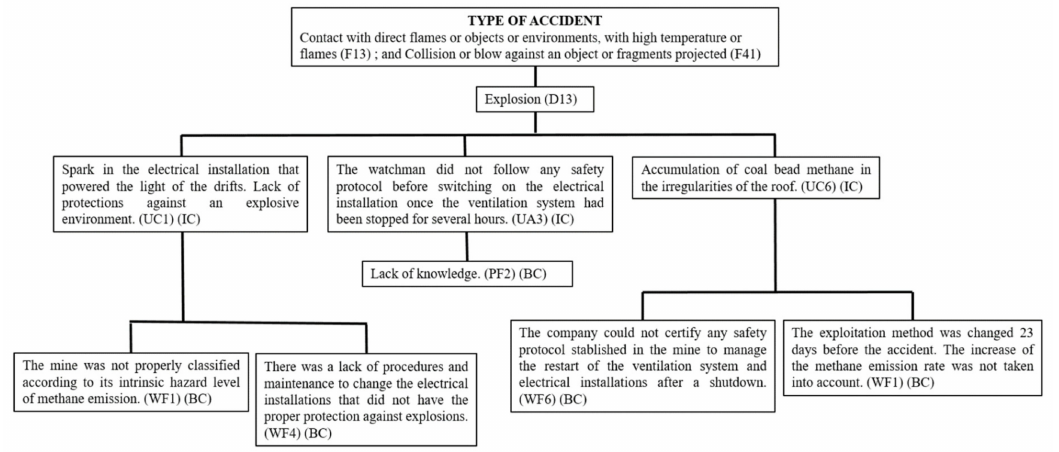
Figure 4. Causal tree using the Spanish Instituto Nacional de Seguridad y Salud en el Trabajo (INSST)